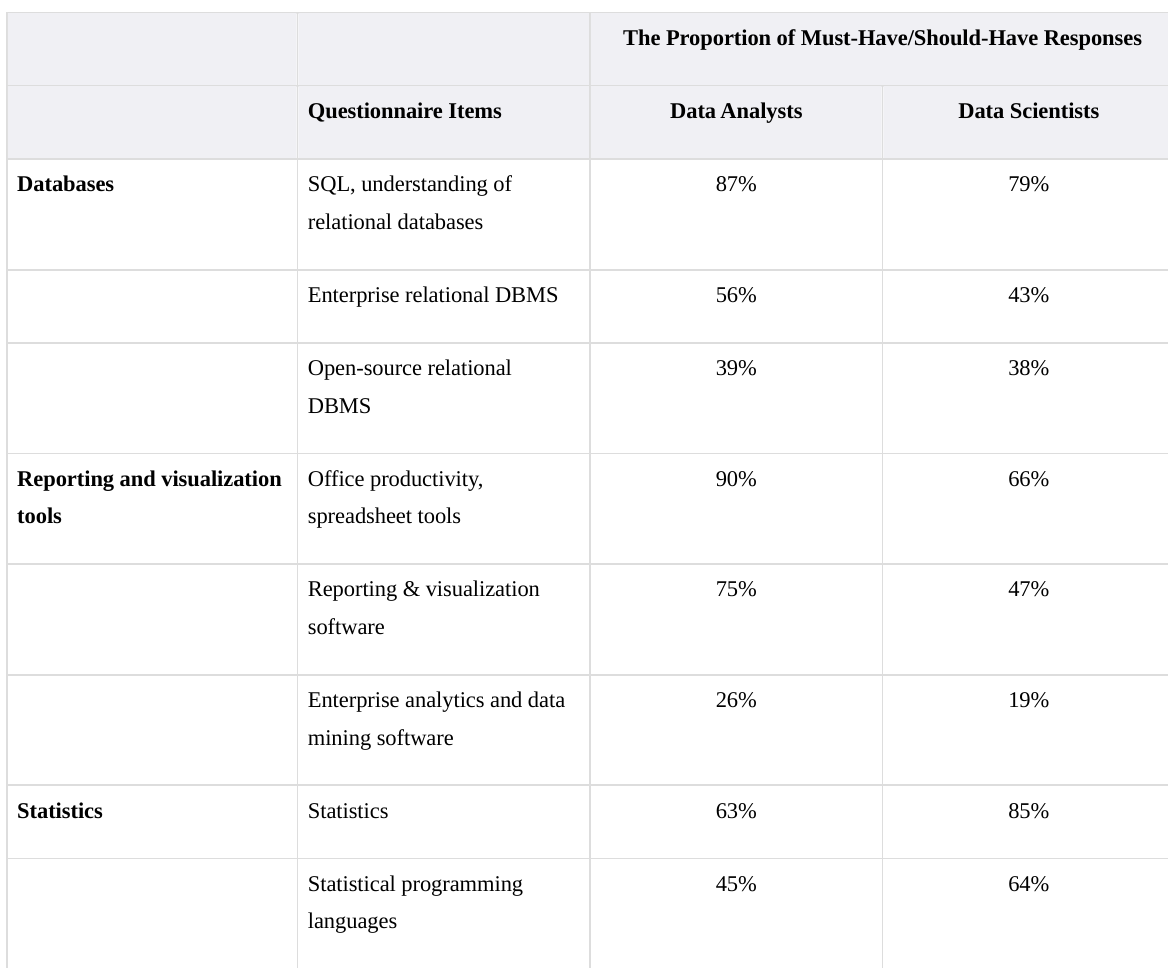
Table 5. The proportions of must-have/should-have responses to selected questionnaire items by data analysts and data